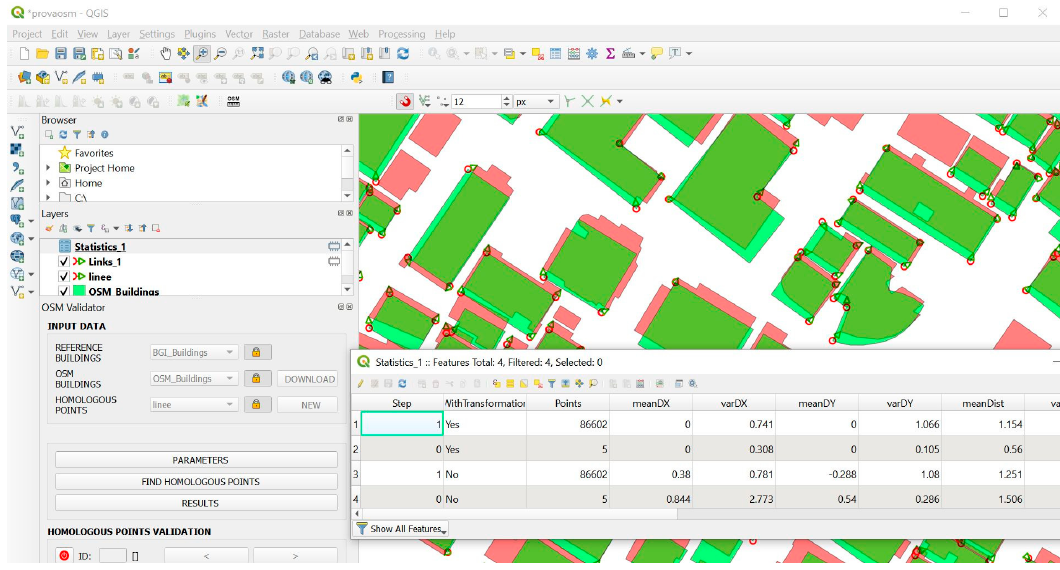
Figure 7. Assessment of OpenStreetMap data with the QGIS plugin OSM_SAA [75].